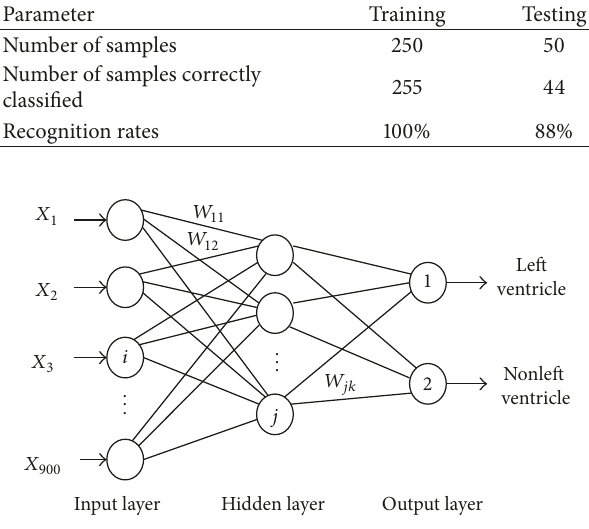
Figure 4: Designed backpropagation neural network (BPNN).